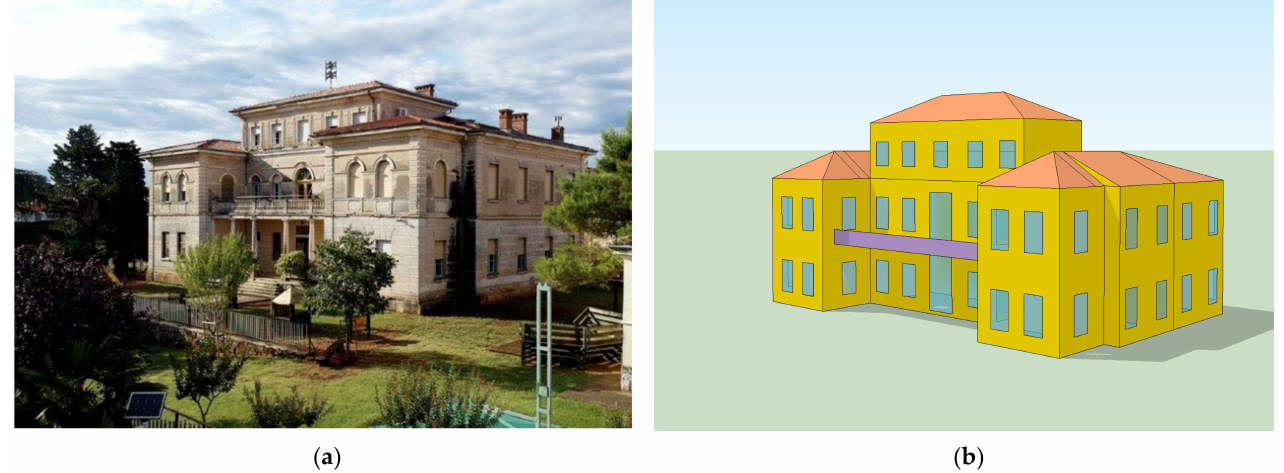
Figure 1. ( a ) Case study building; ( b ) the model created using Google Sketchup with Trnsys3d. Occupancy and operating conditions are acquired from the employed staff. The main model assumptions are described in the following. The nursery is used 5 days a week, from 6 AM to 5 PM, with interruptions in conditioning of spaces outside working hours.